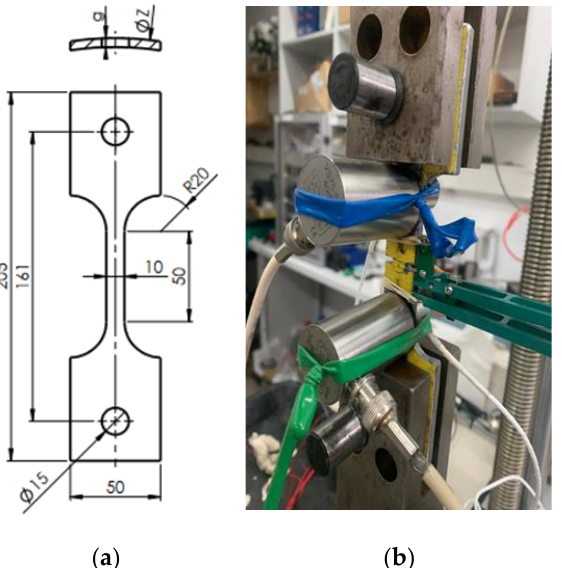
Figure 1. Appearance of the tested specimen: ( a ) technical drawing; ( b ) testing station with the